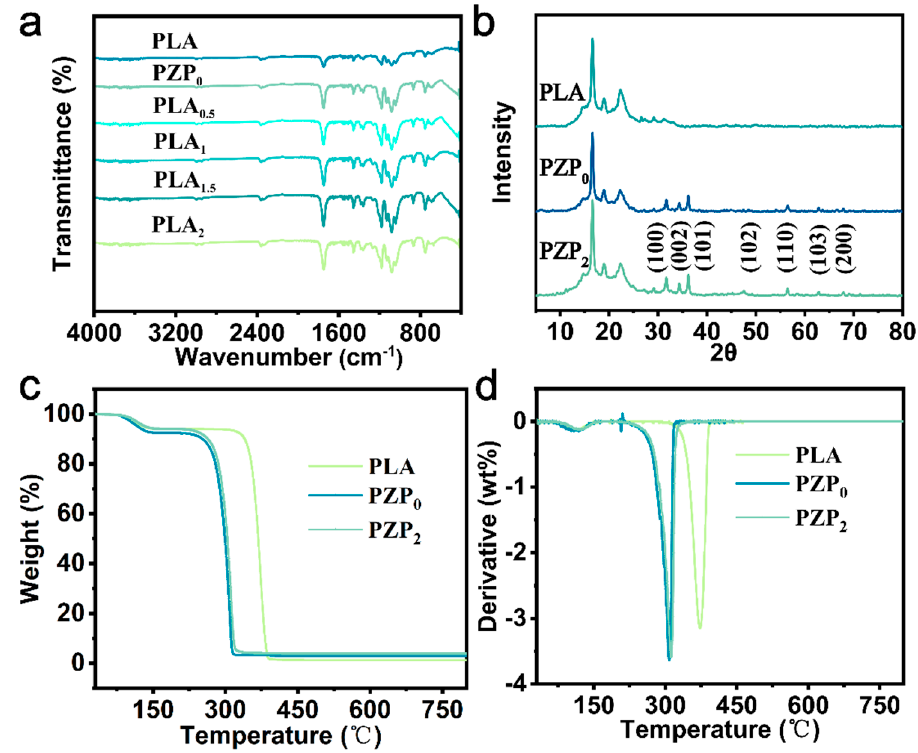
Figure 2. ( a ) FT － IR spectra, ( b ) XRD patterns, ( c ) TGA curves, and ( d ) DTG